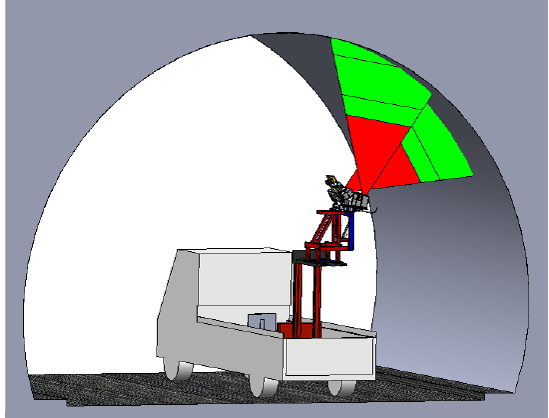
Figure 3. The field of view constraint. The area of correct focus is shown in